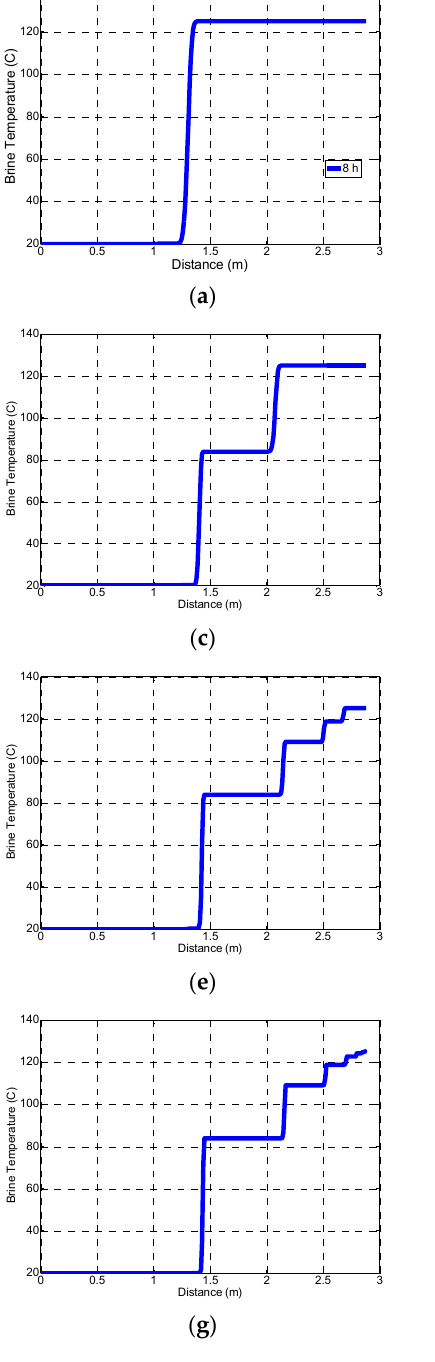
Figure 16. Brine temperature profiles (subfigures a , c , d , e , f , g , h ) and fracture wall temperature profile (subfigure b ) after 8 h on different days, for brine velocity = 0.0001 m/s. ( a ) Day 1; ( b ) day 1; ( c ) day 2; ( d ) day 3; ( e ) day 4; ( f ) day 5; ( g ) day 6; ( h ) day 7.